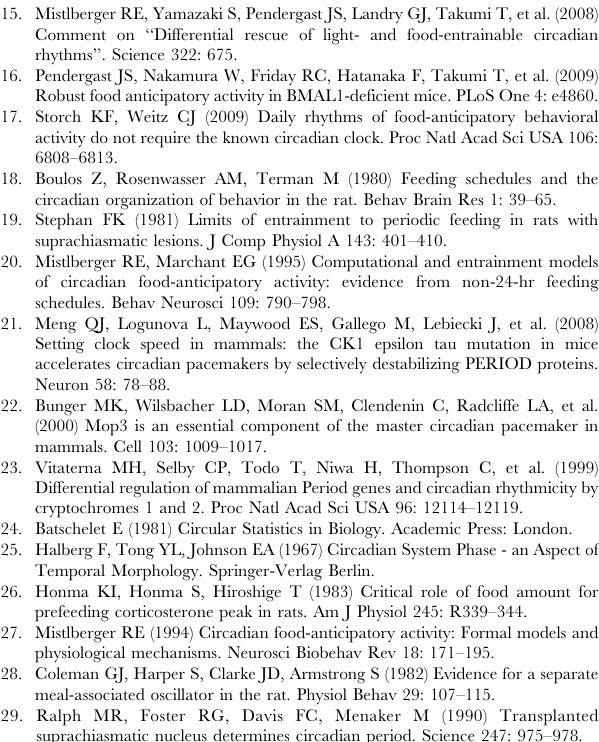
Figure S1 Activity ratios of the SCN-ablated mice on serial feeding schedules. Feeding-time and post-feeding activity ratios were calculated by the fold change of mean locomotor activity in each mouse during the 4-h feeding period and the 2-h post-feeding period, respectively, and were compared with those during the rest of the day. No significant difference was detected in either the feeding-time activity ratio ( A : n= 7, ANOVA, P = 0.88) or the post-feeding activity ratio ( B : P = 0.31) in each T-cycle. (TIF) Figure S2 Activity ratios of the SCN-ablated Cry1 2 / 2 (A,C) and Cry2 2 / 2 (B,D) mice on serial feeding sched- ules. Feeding-time and post-feeding activity ratios were calculated in SCN-ablated Cry1 2 / 2 and Cry2 2 / 2 mice in a similar way as described in the legend of Figure S1. No significant difference was detected in either the feeding-time ( A : Cry1 2 / 2 , n = 8, ANOVA, P = 0.68; B : Cry2 2 / 2 , n =7, P = 0.85) or post-feeding ( C : Cry1 2 / 2 , n =8, P = 0.70; D : Cry2 2 / 2 , n = 7, P =0.16) activity ratios in each T-cycle.